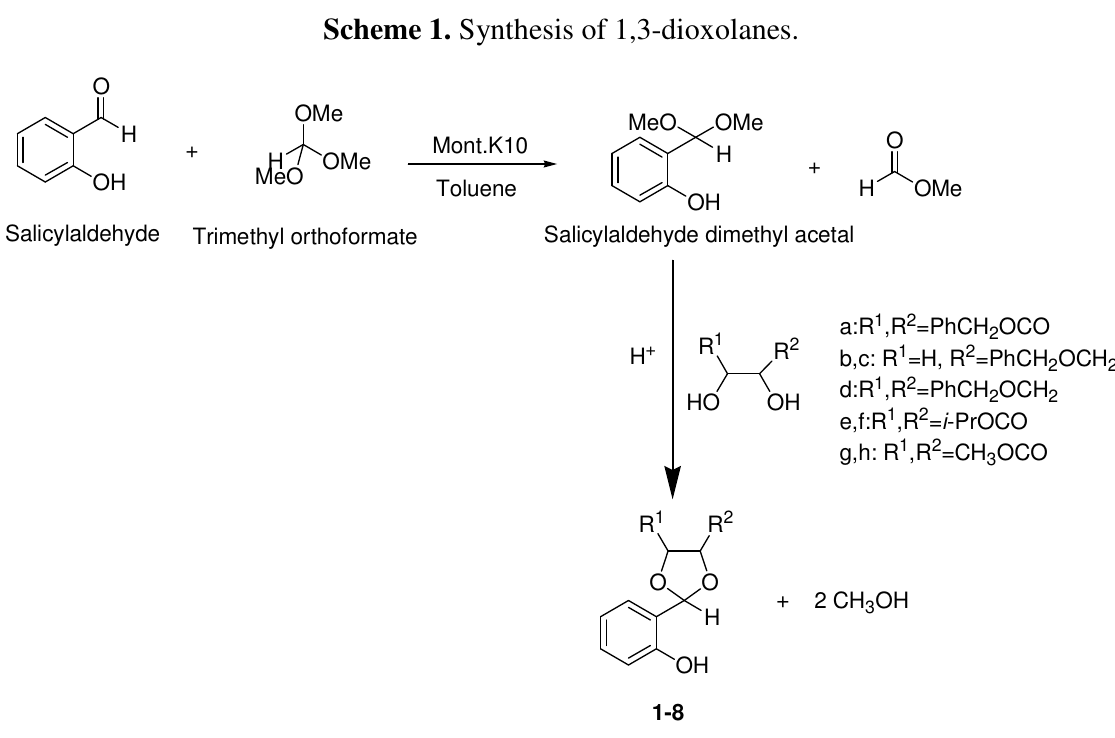
Table 1. Acetalization of salicylaldehyde with diols a-h by Montmorillonite K10 catalyst.